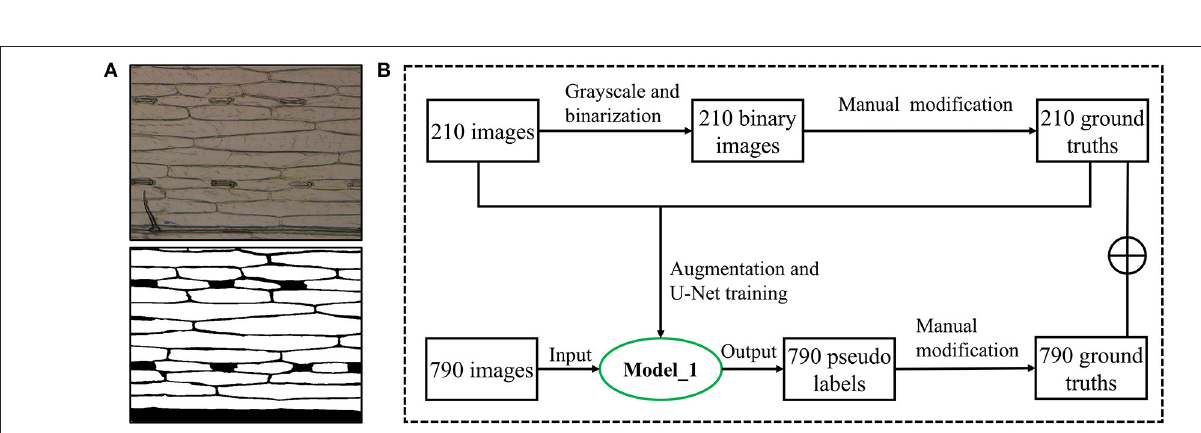
Frontiers in Plant Science |